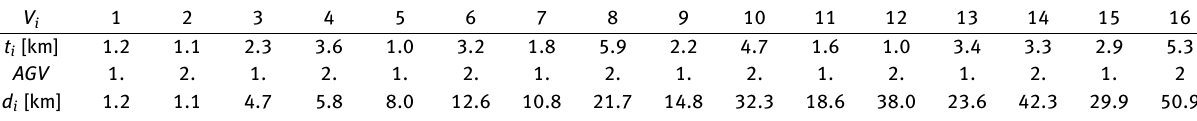
Table 2: Calculation of the d i parameter based on distances between V 0 and V i for two AGVs V i